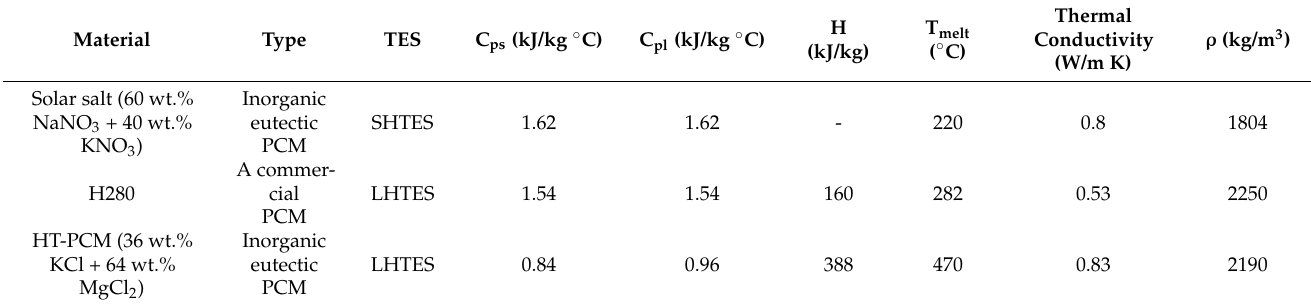
Table 6. Thermophysical properties of the storage materials selected for TESs.